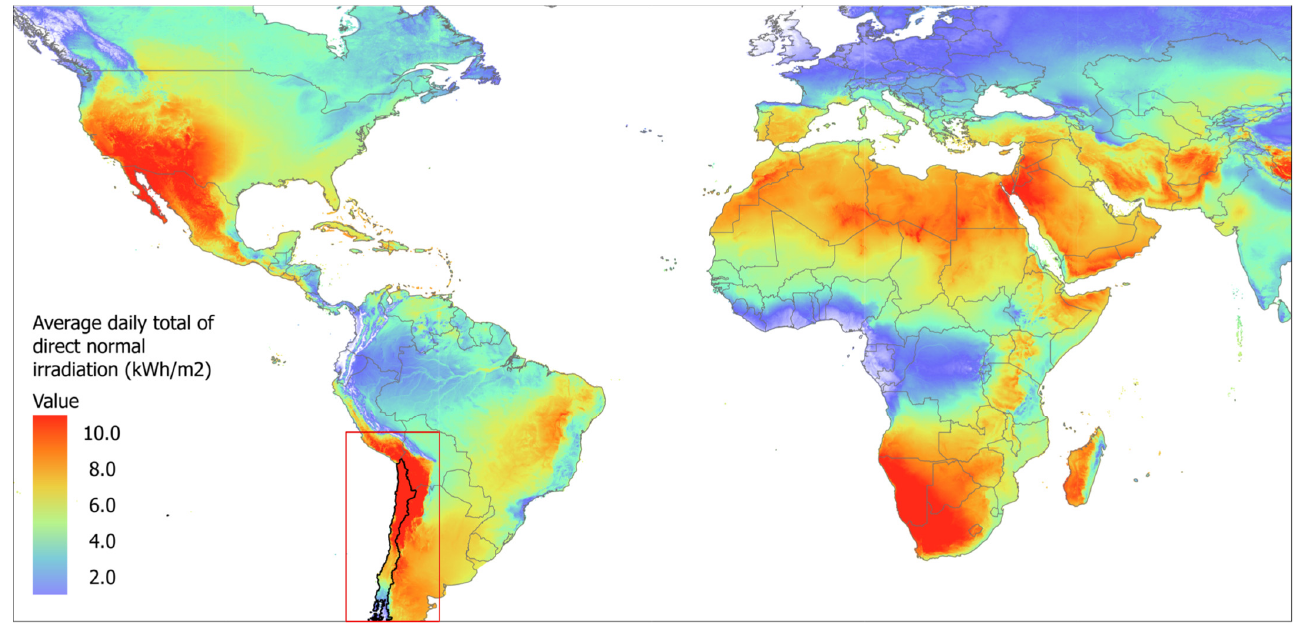
Figure 1. Direct normal irradiation (DNI) in Chile and other countries.